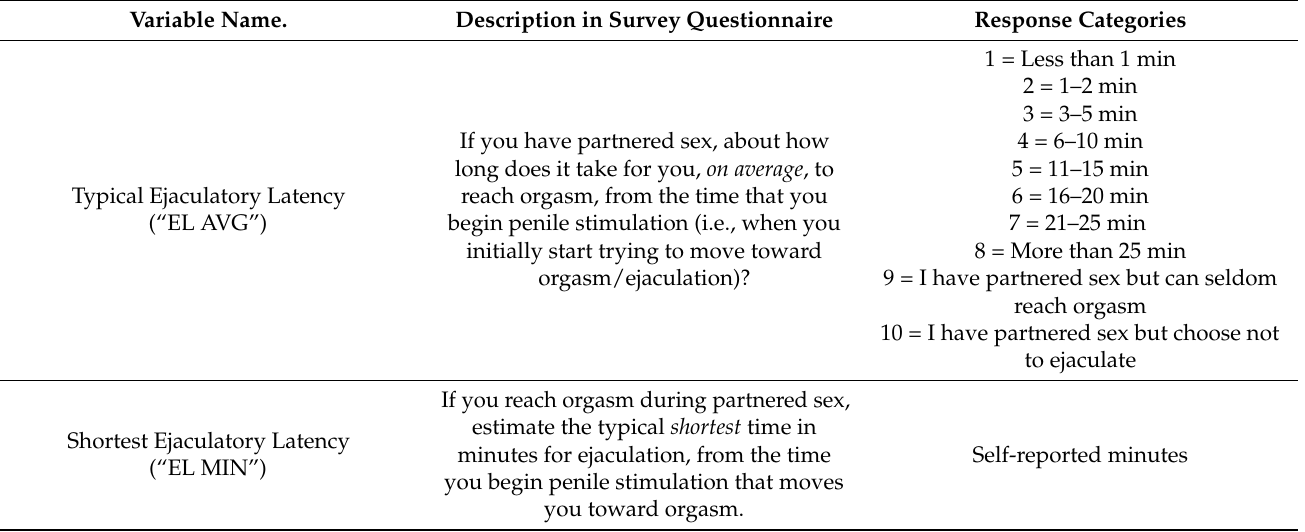
Table A1. Description of variables and response options in consideration for diagnostic criteria for DE. Variable